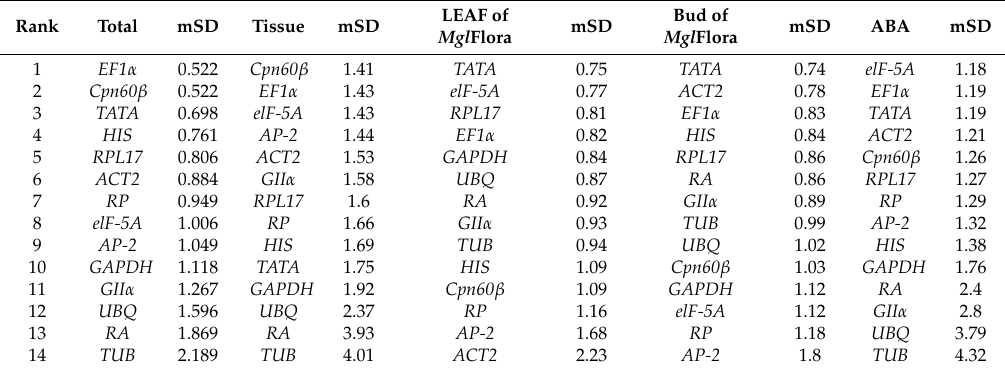
Table 2. Candidate reference gene ranking based on ∆ Ct method.